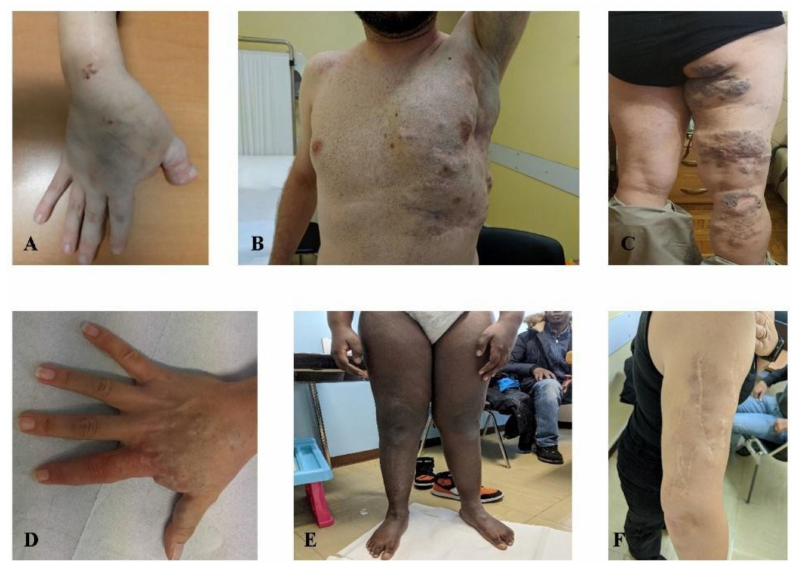
Figure 3. Venous malformations. ( A ) patient 17, ( B ) patient 18, ( C ) patient 21, ( D ) patient 22, ( E ) patient 23, ( F ) patient 26. Photos not available: patients 19, 20, 24, 25. In the latest series of four patients affected by lymphovenous malformations (Figure 4), NGS-liquid biopsy analysis detected MET and FGFR3 somatic variants in three out of four individuals. In two of them (patients 13 and 14) FGFR3 and MET variants were mutually exclusive, while in two of them (patients 15 and 16) were simultaneously present. The same c.3029C > T ( p .(Thr1010Ile)) MET variant was detected in cfDNA of both patients 13 and 16 with a VAF of 0.32% and 0.97%, respectively. NGS-tissue analysis, available for patient 15, confirmed mosaicism for the FGFR3 variant at the malformation site with a molecular frequency of 0.59%. The distribution of all identified genomic alterations is shown in Table 1.